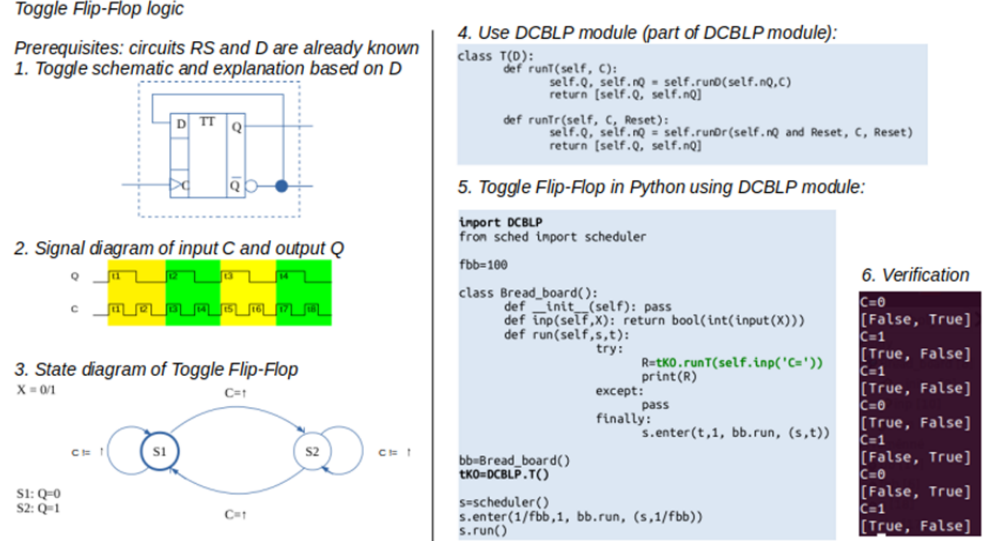
Figure 8. Illustration of the steps to be taken during the sequential logic training in experimen- tal